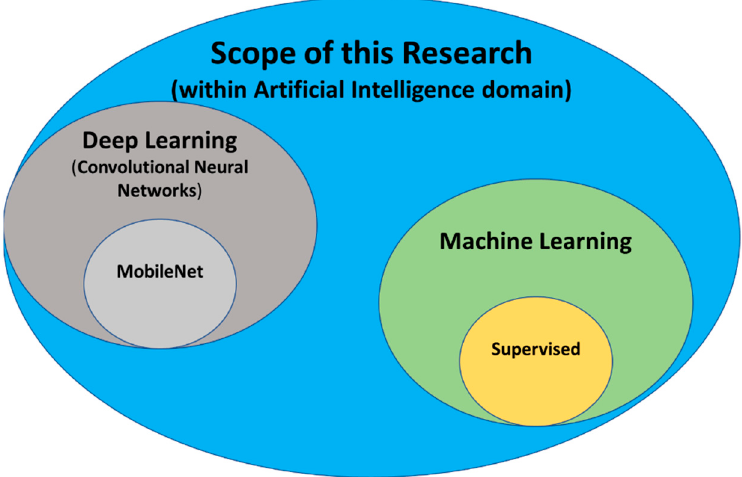
Figure 1. Scope of this research within the artificial intelligence domain.